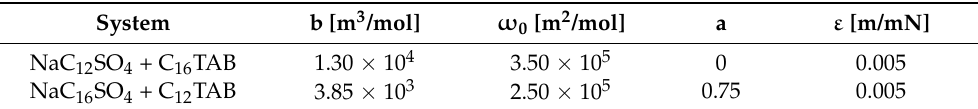
Table 1. Parameter values obtained by fitting the Frumkin adsorption model Equations (1)–(3) to the experimental data of Figure 1.